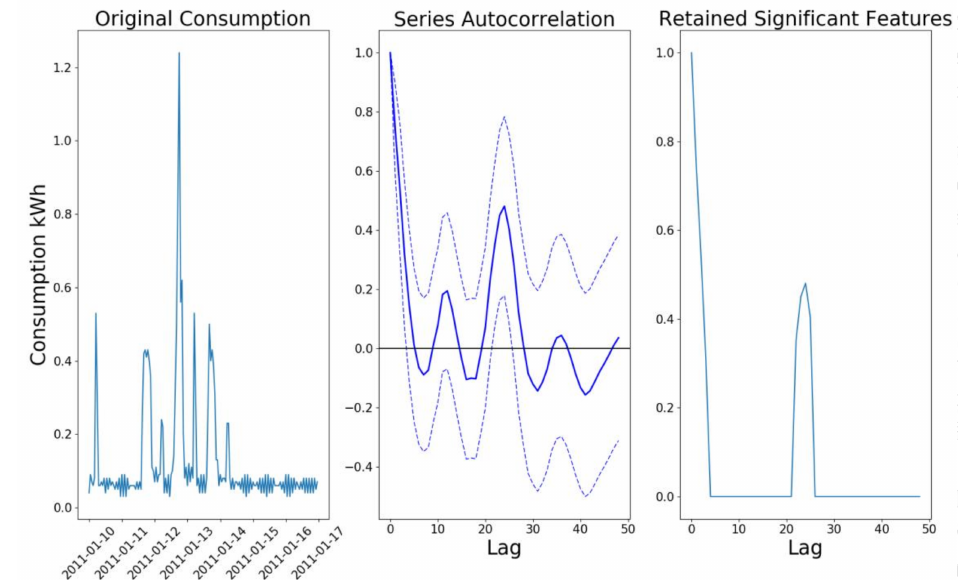
Figure 6. ( Left ) The original consumption profile, ( Middle ) the solid line is the autocorrelation coefficient, dashed lines are the 95% confidence intervals. ( Right ) Significant autocorrelation coefficients retained as meter features and applied as input to K-Means clustering. The significant lags include lags from the first five lags and a recurrence at around lag 20, indicating some periodicity in the consumption. The significant lags are distinct from the lags in Figure